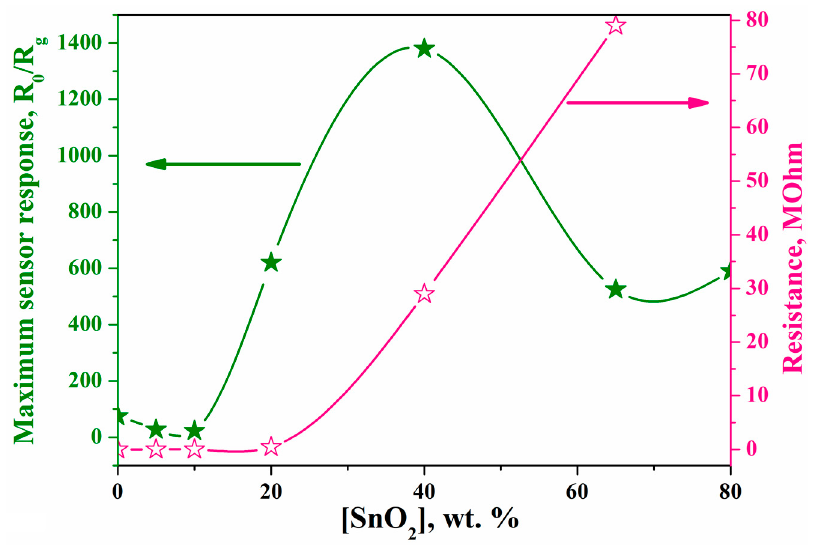
Figure 2. Dependence of the maximum sensor response at 1100 ppm H 2 (green stars) and the resistance of the SnO 2 –In 2 O 3 composite (red stars) on the content of tin oxide.